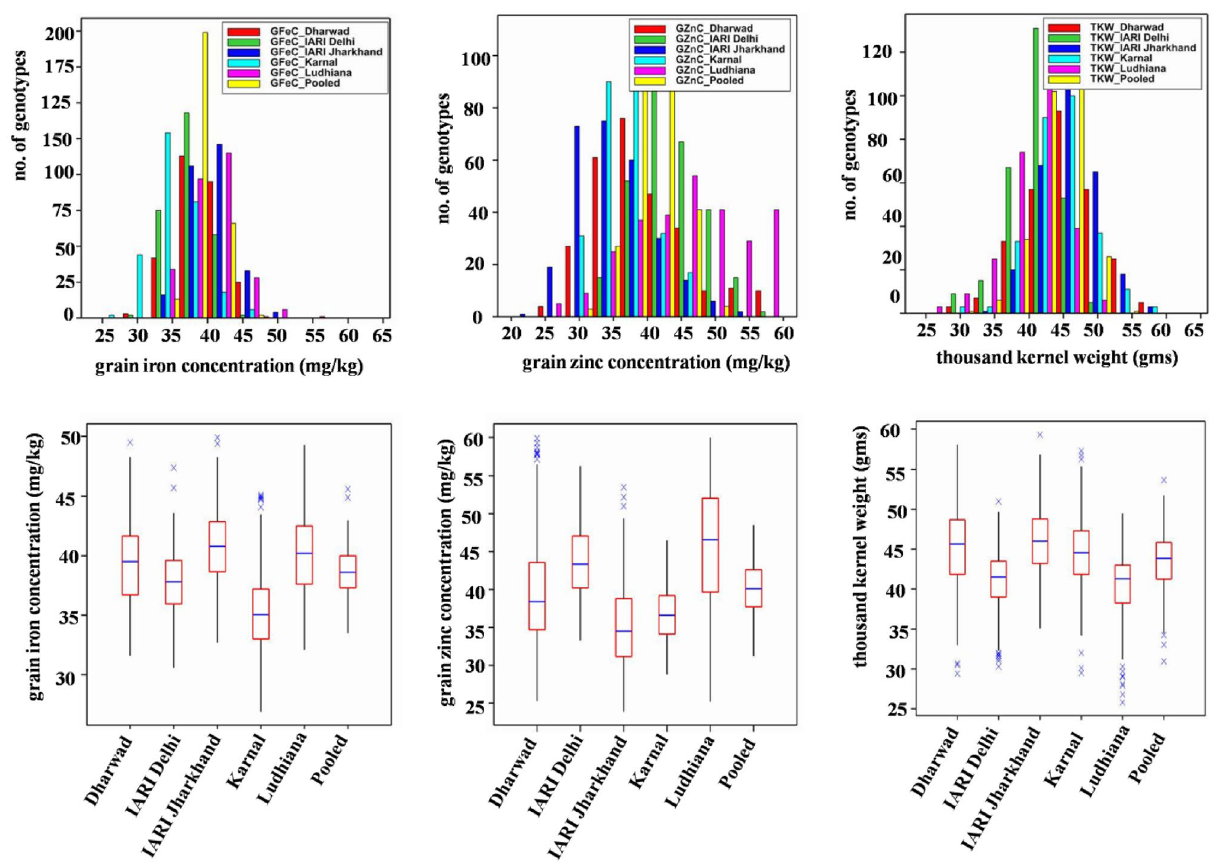
Figure 1. Frequency distribution and boxplots of grain quality traits in GWAS panel evaluated at Dharwad, IARI Delhi, IARI Jharkhand, Karnal, and Ludhiana during 2020–2021. Chromosome-wise SNP Genome